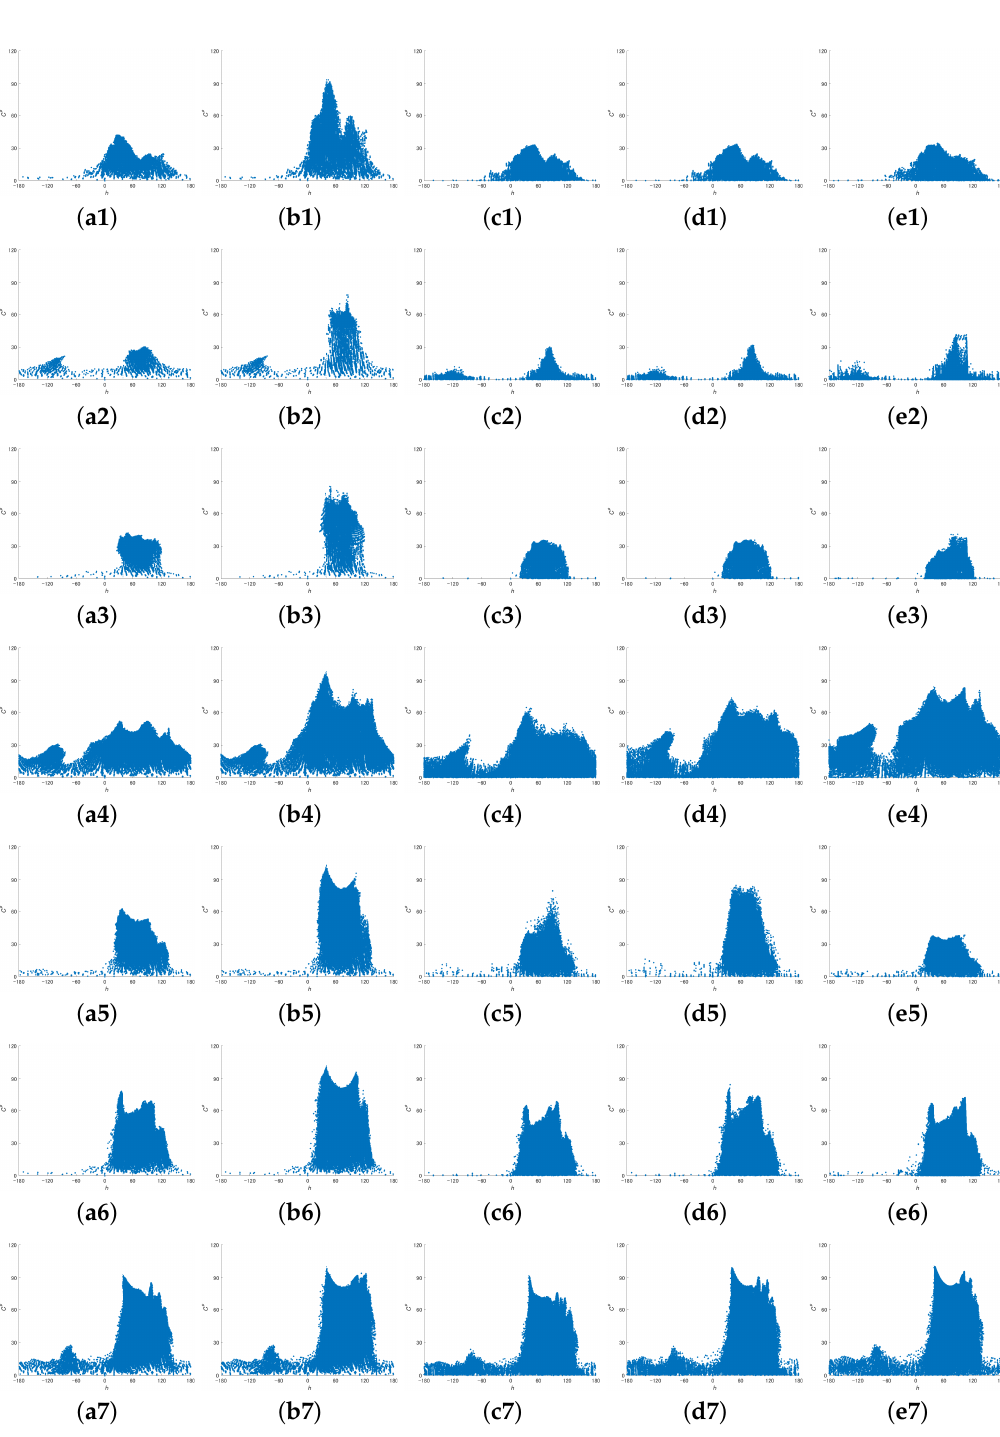
Figure 7. Scatter plots of hue and chroma corresponding to Figure